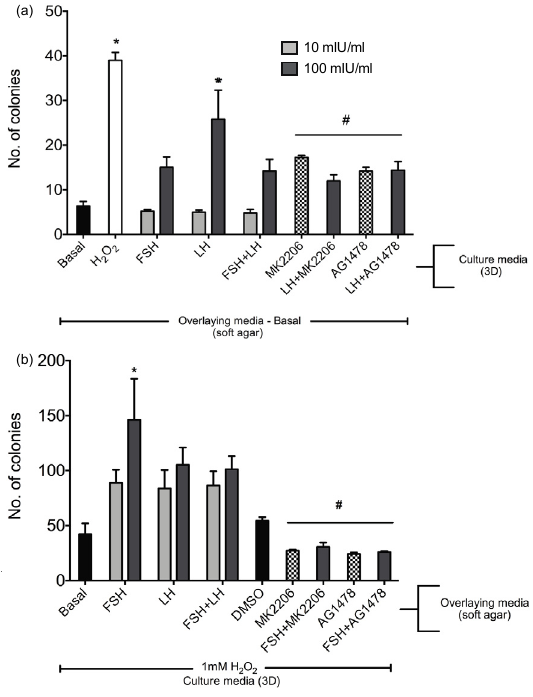
Figure 6. LH treated OSE increased anchorage independent growth. ( a ) OSE from 3D organoids cultured in 100 mIU/mL LH demonstrated an increase in colony formation when compared to basal cultured organoids that could be blocked with MK-2206 and AG1478 O and overlaid with FSH showed an increase in colony whereas ( b ) OSE cultured in 1 mM H 2 2 formation compared to OSE overlaid with basal medium that could be blocked with MK-2206 and AG1478. * different than basal; p < 0.05, “#” is different than * p <